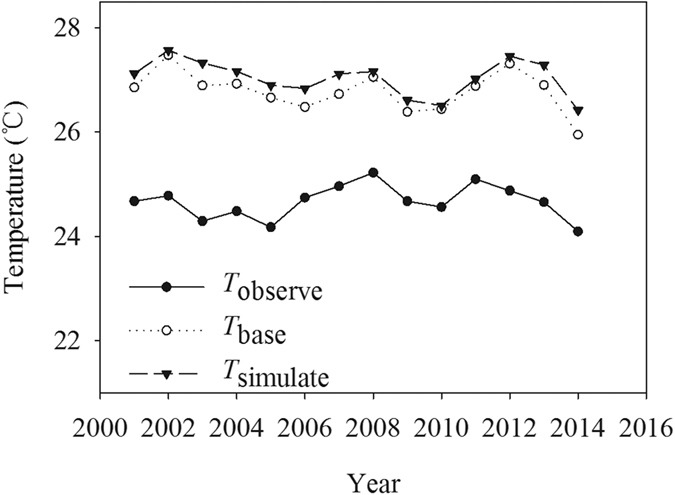
Average values of Tobserve, Tsimulate and Tbase in the entire Tarim Basin during summer from 2001 to 2014.The Tsimulate in the desert and oases was calculated based on LST image data by the fitting formulas in Fig. 4a,b, respectively.